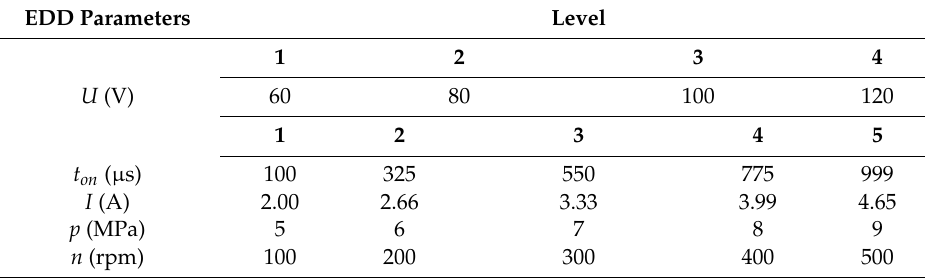
Table 5. Research plan and the results of the experiments. * the blind hole. Exp.